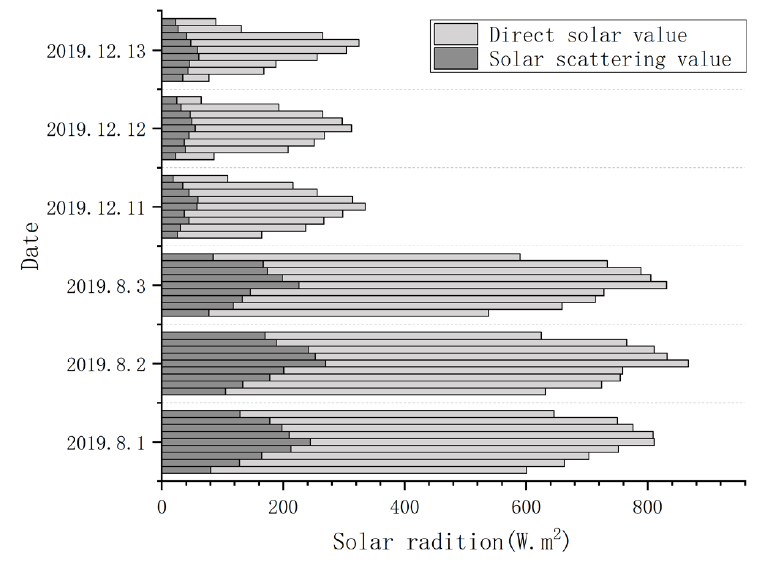
Figure 6. Solar radiation actual measurement data.